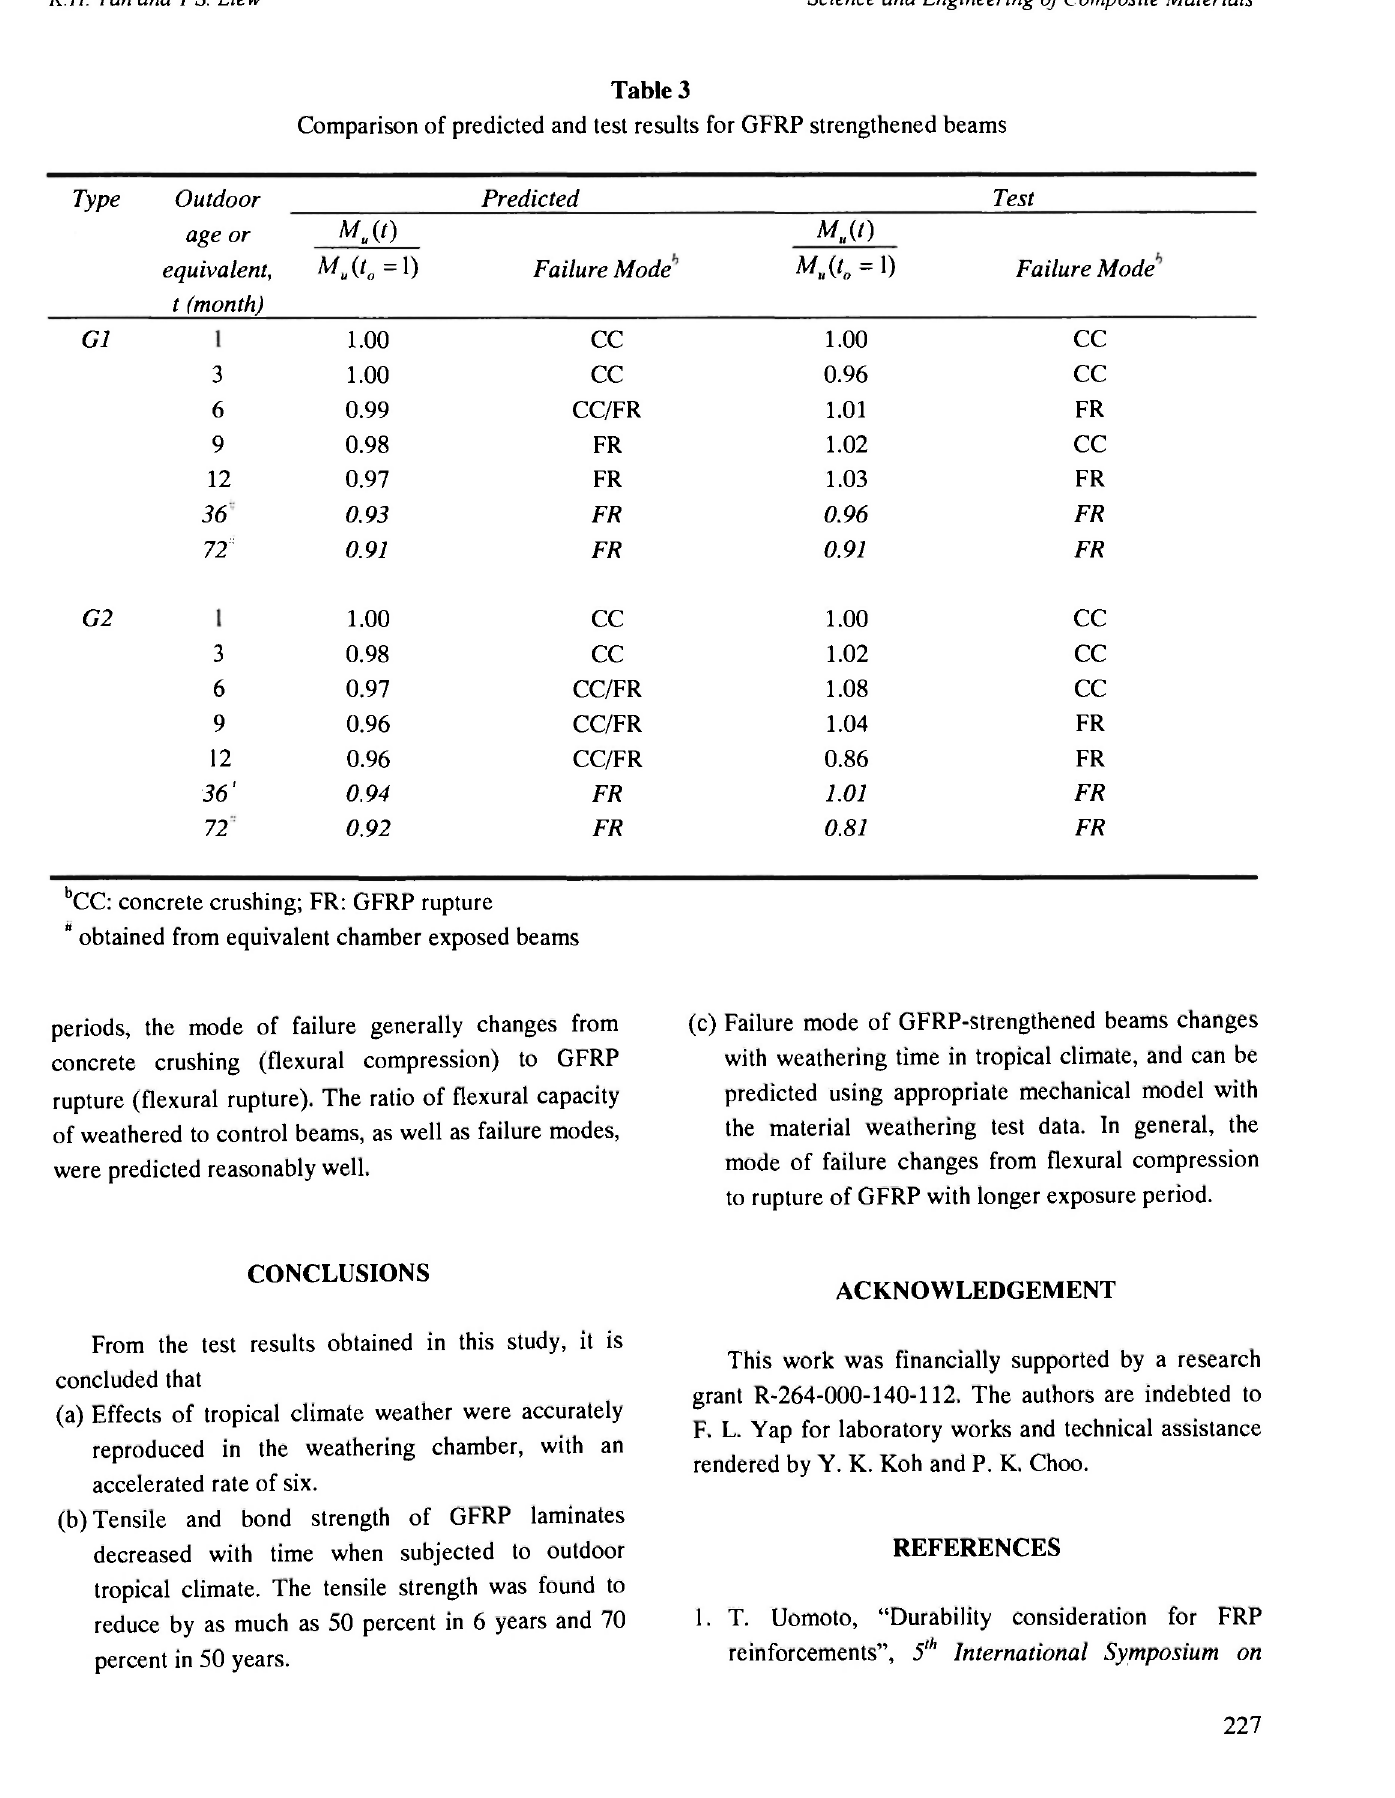
Comparison of predicted and test results for GFRP strengthened